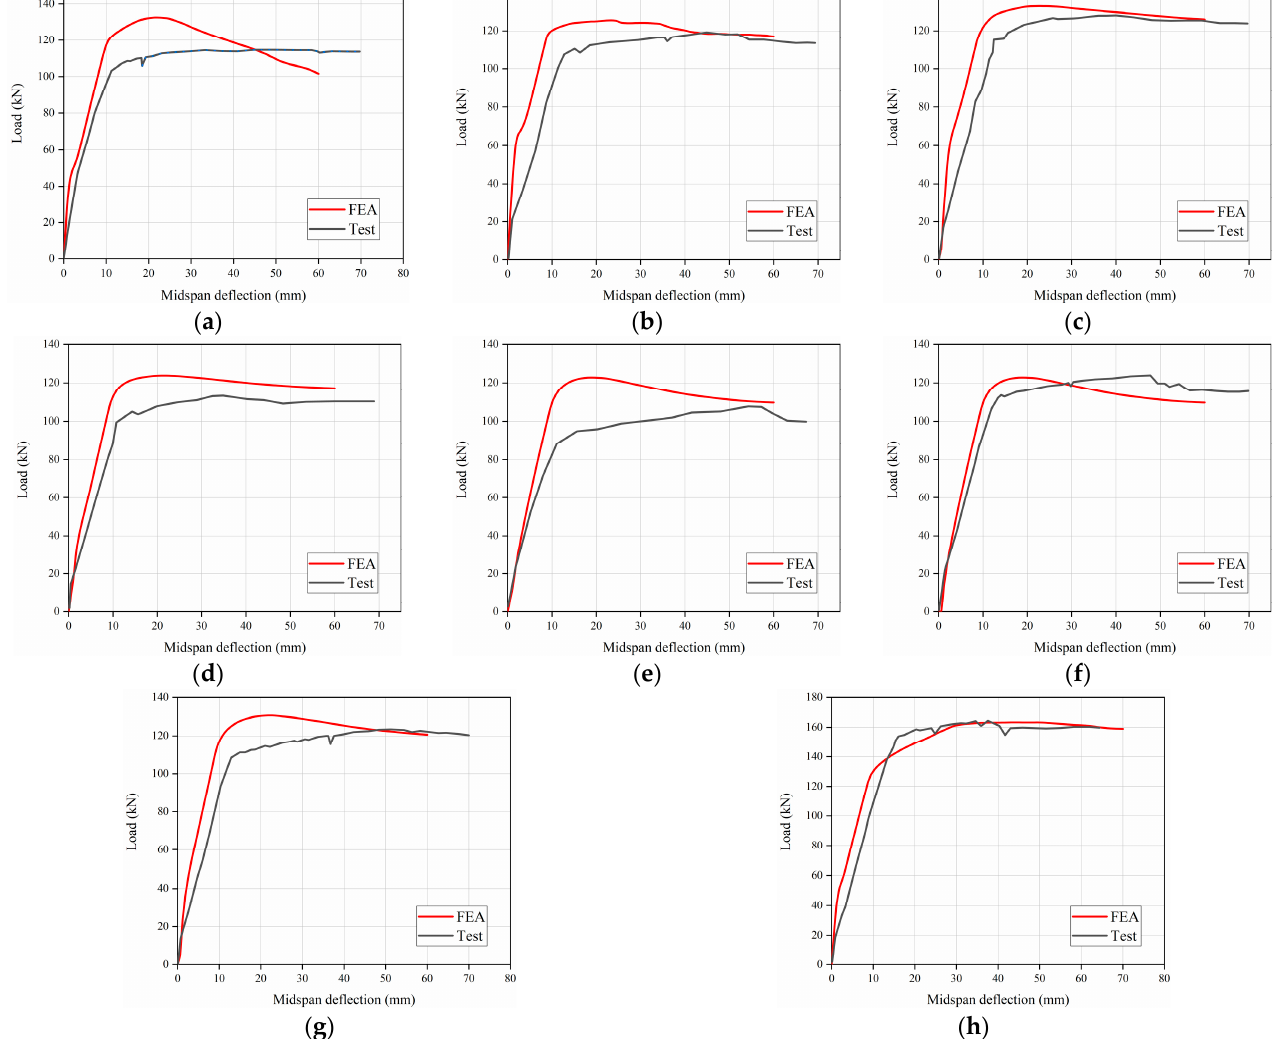
Figure 5. Load–deflection curves between test and FE results. ( a ) C30R50F1, ( b ) C45R30F1, ( c ) C45R50F2, ( d ) C45R100F1, ( e ) C45R50F0, ( f ) C45R50F1, ( g ) C60R50F1, ( h ) C45R0F1 .